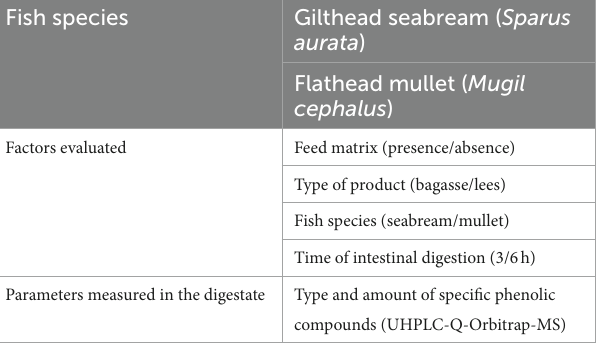
TABLE 2 Conditions used and parameters measured on the in vitro experiment aimed to test the effect of feed matrix in the bioavailability of wine